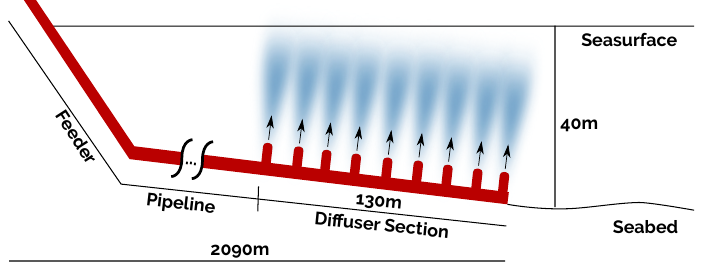
Figure 2. Marine outfall